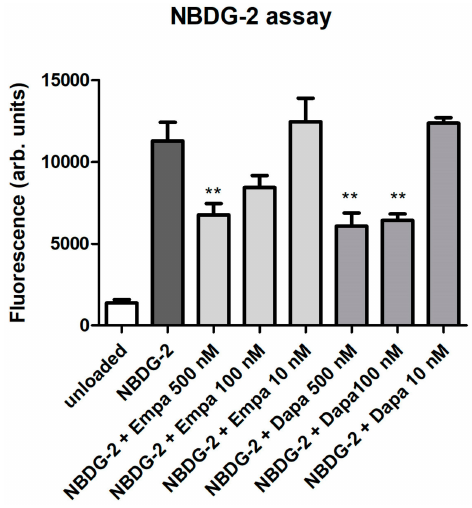
Figure 2. Functional assay. NBDG-2, a fluorescent glucose analog, was used to monitor glucose uptake in cultured PTCs. NBDG-2 was added either alone or with decreasing concentrations of gliflozins (500, 100, 10 nM) for 60 min at 37 ◦ C. Cells incubated in bu ff er without NBDG-2 were used as background controls (unloaded). Fluorescence was measured using a fluorescence reader with excitation and emission wavelengths of 485 and 538 nm (arbitrary units, mean ± standard deviation (SD), n = 4, ** p < 0.01 versus